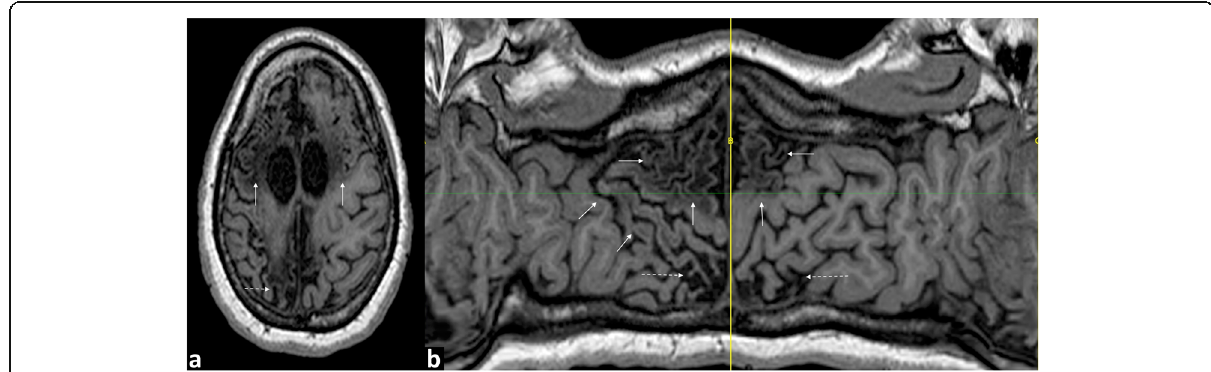
Fig. 11 a Axial T1W image and ( b ) flat earth Mercator map derived from a curved reconstruction of a 3D T1 sequence in a 16-year-old girl who sustained a partial-prolonged HII at term gestation, demonstrating predominantly anterior watershed and parasagittal volume loss with cystic encephalomalacia, within this involved area, in continuity (solid white arrows) as well as posterior watershed volume loss (dashed white